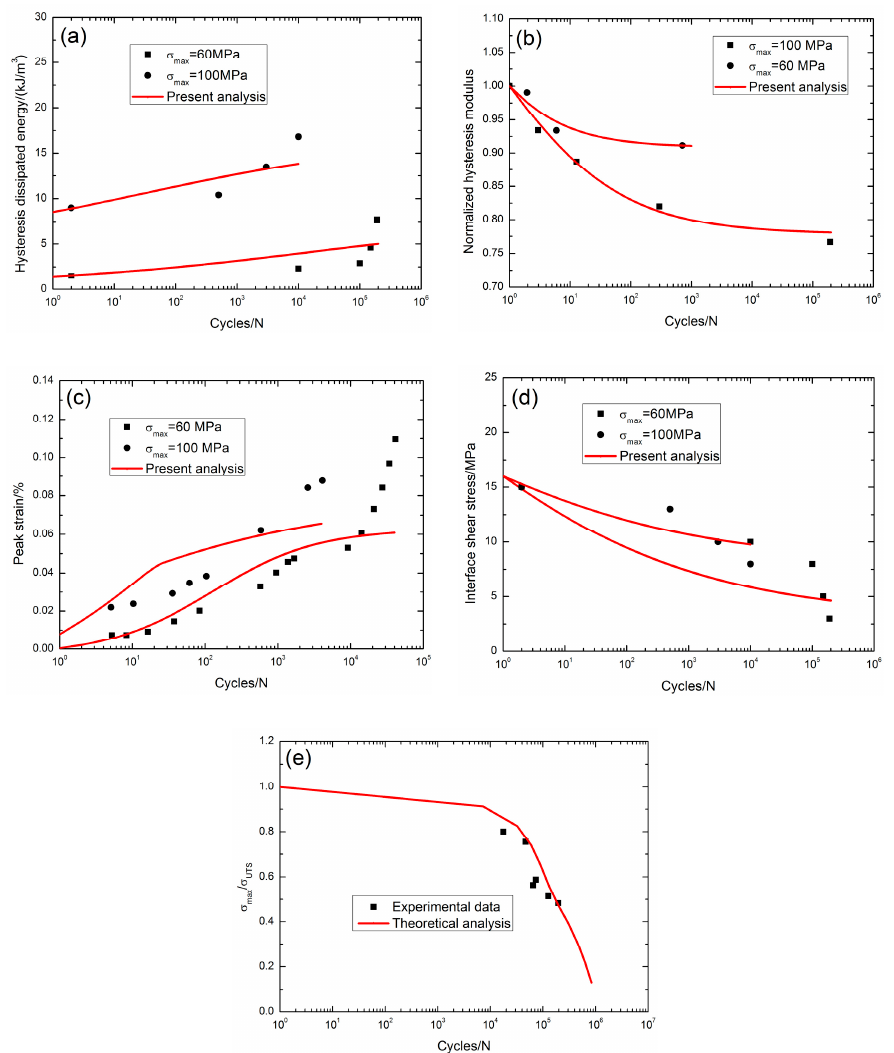
Figure 4. ( a ) The fatigue hysteresis dissipated energy versus applied cycles; ( b ) the normalized hysteresis modulus versus applied cycles; ( c ) the peak strain versus applied cycles; ( d ) the interface shear stress versus applied cycles; and ( e ) the fatigue life S-N curves of 2D SiC/SiC composite at 1000 °C in steam [3].